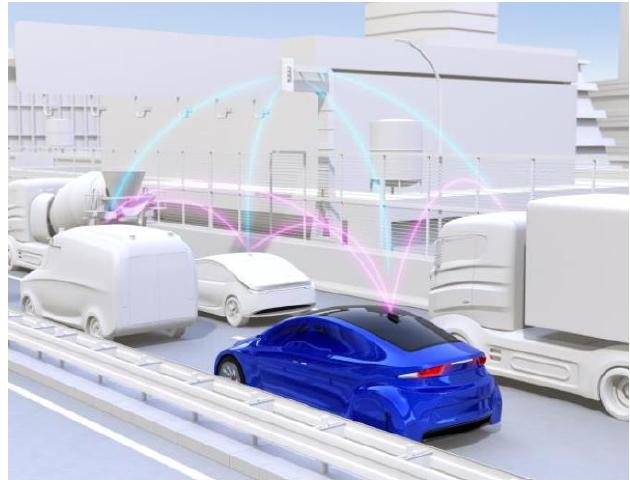
Figure 5. Example of an RSU device function scheme [15].